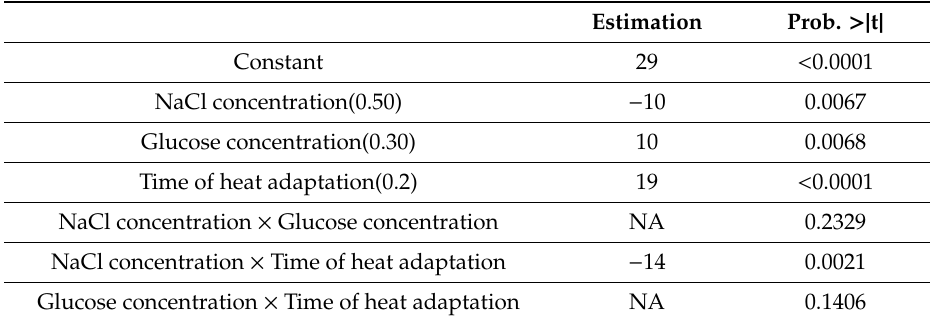
Table 3. Coe ffi cient estimation of the di ff erent variables and their interaction on P. freudenreichii viability during oxidative challenge. NS: